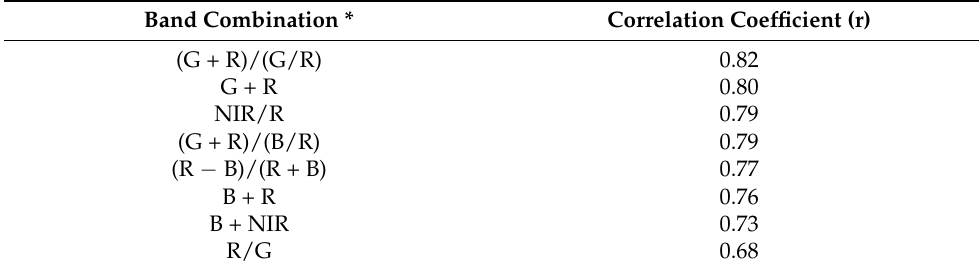
Table 2. Correlation analysis of band combination and TSS. Band Combination * Correlation Coefficient